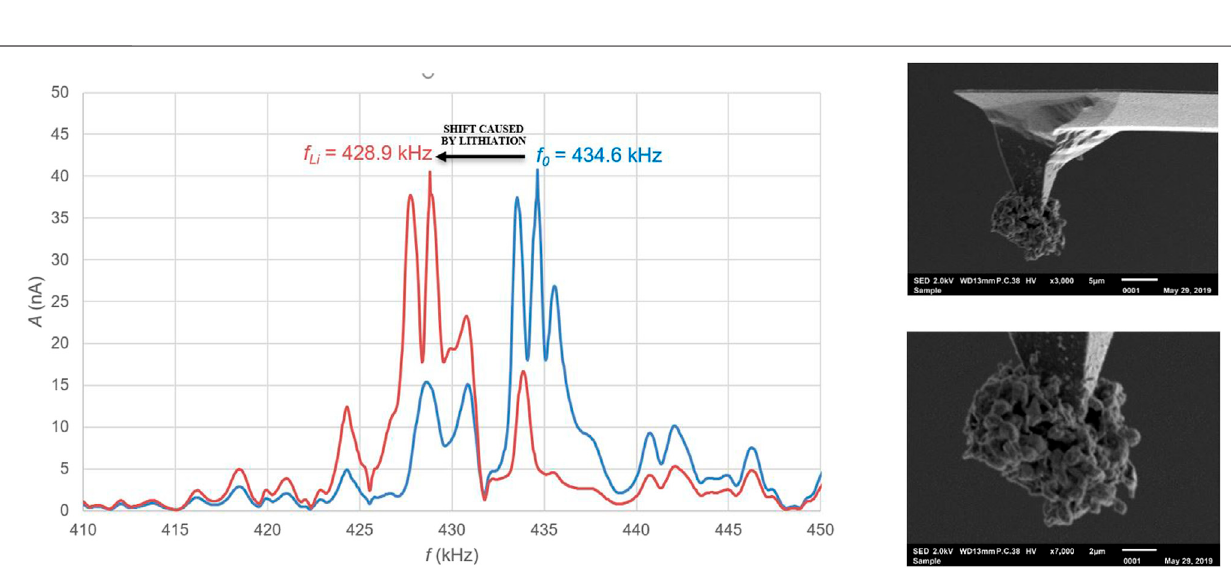
Frontiers in Chemistry |